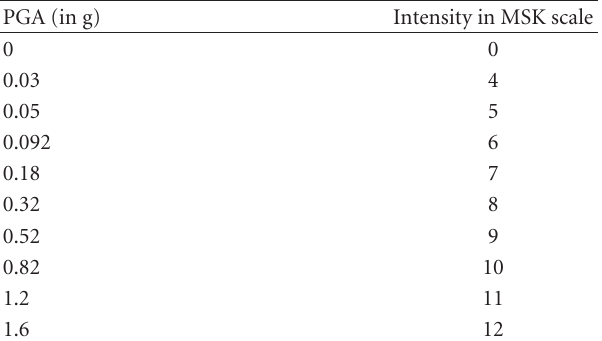
Table 4: PGA-MSK intensity conversation